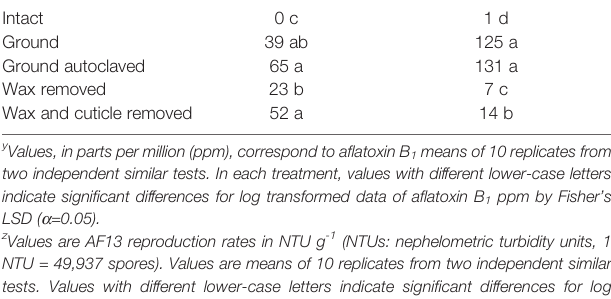
TABLE 3 | A fl atoxin B 1 and spore production by Aspergillus fl avus AF13 in kernels of R-MLR 2006-23 subjected to fi ve treatments. Treatment